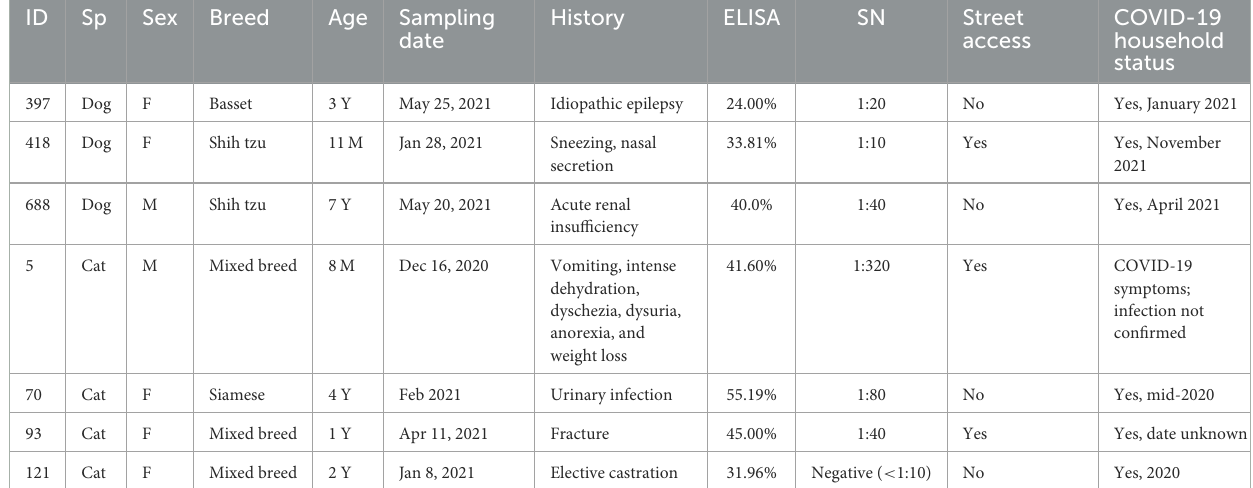
TABLE 1 Epidemiological data on dogs and cats that were seropositive for SARS-CoV-2 through serum neutralization (SN)